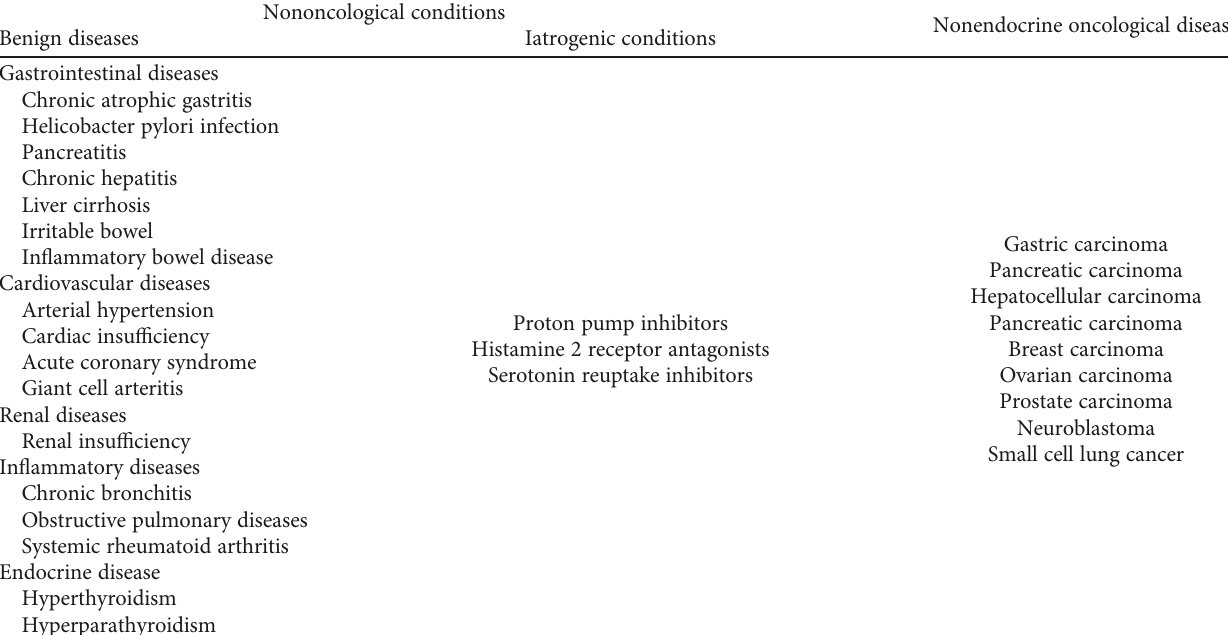
Table 2: Causes of Cg A elevation unrelated to